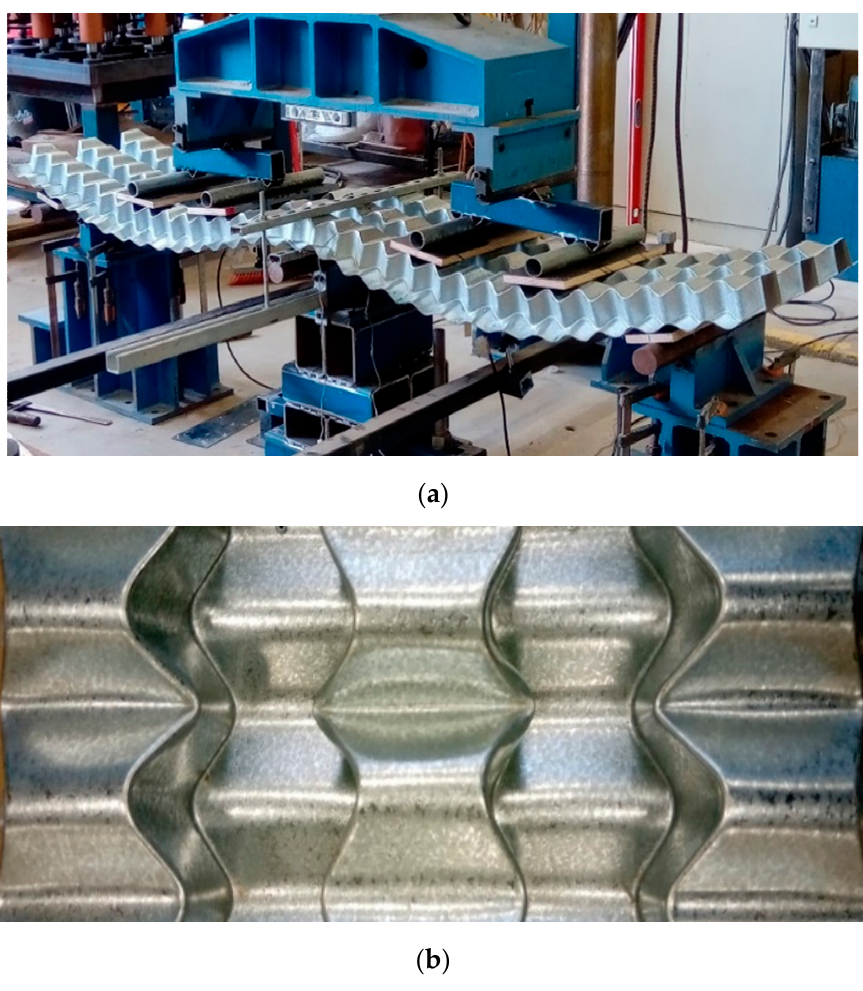
Figure 16. Failure pattern of the tested continuous span decks: ( a ) deformed shape of the continuous span deck (CSD); and ( b ) local squashing observed at internal support.